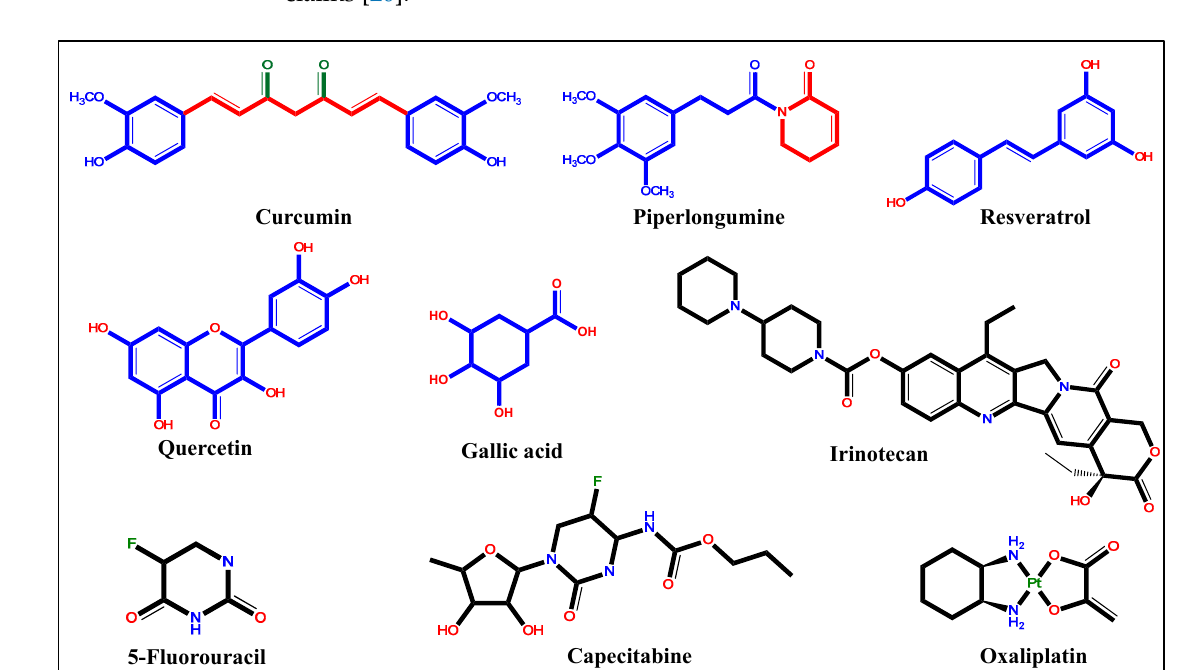
Figure 1. Structure of anticancer drugs used in the treatment of colon cancer.